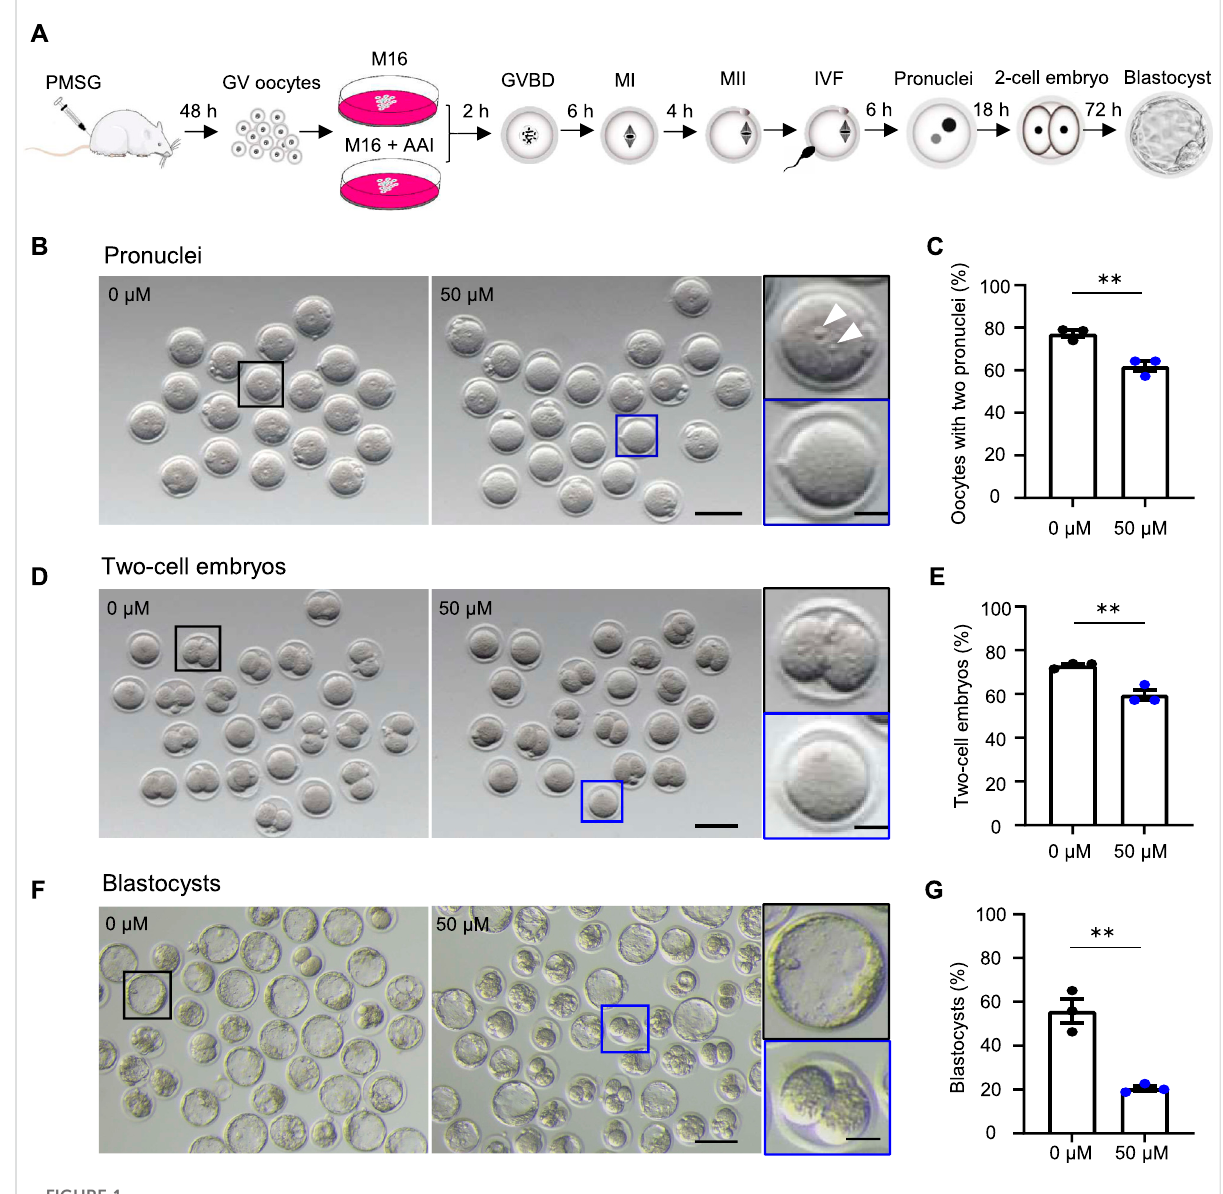
FIGURE 1 AAI exposure to oocytes decreases the fertilization rate and embryonic development potential in mice. (A) Schematic of experimental design. (B – G) The fully grown GV oocytes retrieved from mouse ovaries were matured in the medium supplemented with 0 or 50 μ M AAI for 12 h to reach the metaphase II (MII) stage. The MII oocytes were performed in vitro fertilization (IVF) for 6 h and two pronuclei were examined (B,C) . All oocytes werethentransferredintoanembryonicculturemediumandculturedfor18 handtwo-cellembryoswereexamined (D,E) .Afterbeingcultured for another 72h, blastocysts were examined (F,G) . (B) Representative images showing the two pronuclei after IVF. Scale bar, 100 μ m. Black box and the enlarged picture showing an MII oocyte with two pronuclei (top, white arrowheads); blue box and the enlarged picture showing an MII oocyte without a pronucleus (bottom). Scale bar in the enlarged picture, 25 μ m. (C) The percentage of oocytes with two pronuclei in (B) . (D) Representative images showing two-cell embryos. Scale bar, 100 μ m. Black box and the enlarged picture showing a two-cell embryo (top); blue box and the enlarged picture showing a zygote or an unfertilized oocyte (bottom). Scale bar in the enlarged picture, 25 μ m. (E) The percentage of two-cell embryosin (D) . (F) Representative imagesshowingtheblastocysts.Scalebar,100 μ m.Blackbox andtheenlargedpictureshowingablastocyst(top); blue box and the enlarged picture showing a two-cell embryo (bottom). Scale bar in the enlarged picture, 25 μ m. Error bar, mean ± SEM of 3 independent experiments (C , E , G) . Totally, 56 and 49 MII oocytes from 0 to 50 μ M AAI treatments for IVF, two pronuclei, and two-cell embryos, respectively (C,E) . 140 and 316 MII oocytes from 0 to 50 μ M AAI treatments for IVF and blastocysts, respectively (G) . **, p < 0.01; two-tailed t